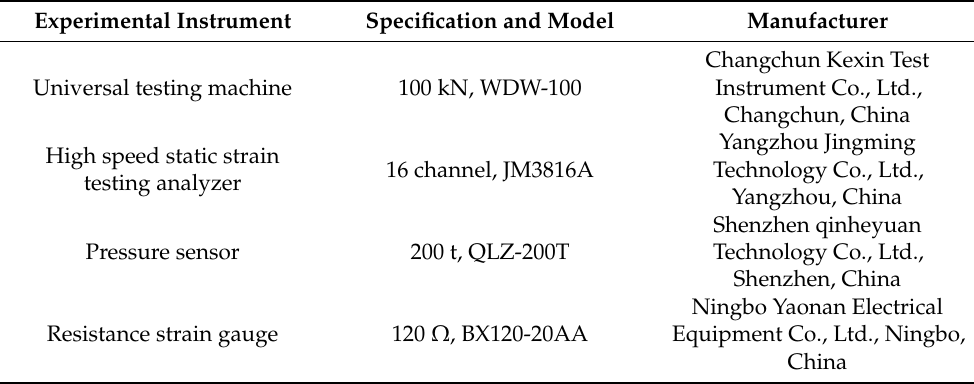
Table 2. Main test instruments and equipment. Experimental Instrument